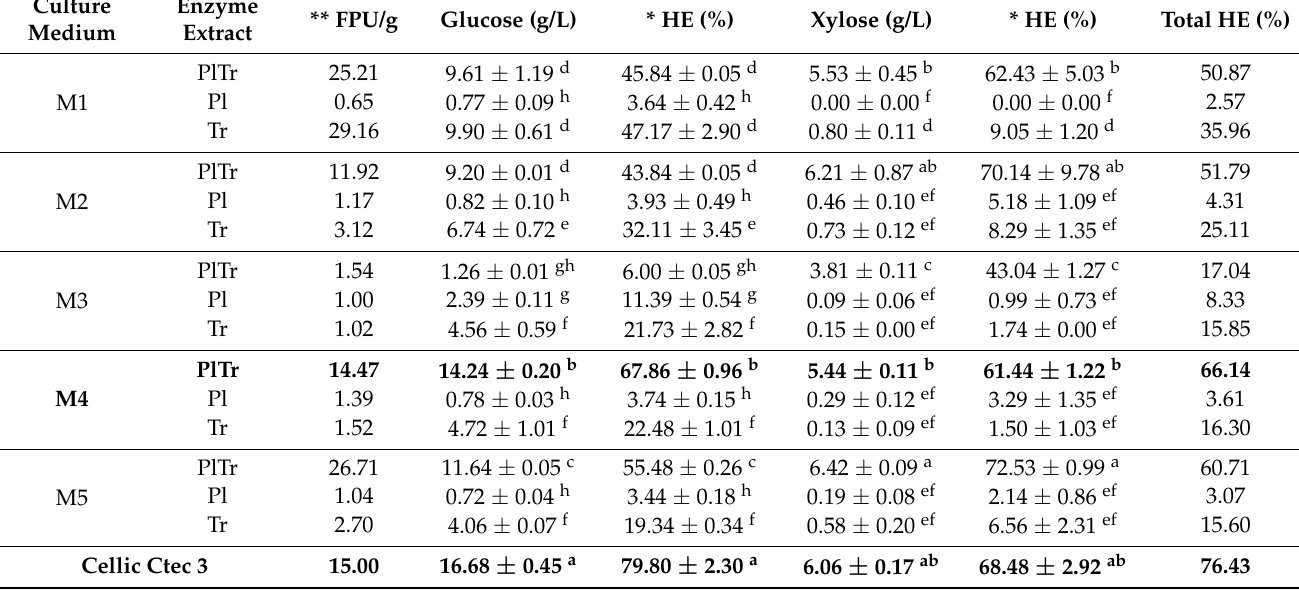
Table 3. Glucose/xylose released and hydrolysis efficiency of crude enzyme extracts of monocultures and co-cultures of P. lecomtei (Pl) and T. reesei (Tr). The fungi were cultured in submerged